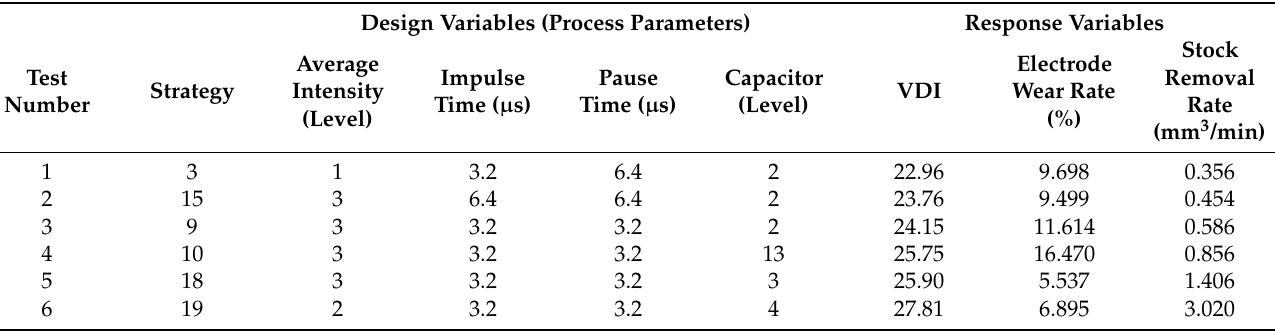
Table 12. Results of ADM copper electrode EDM test.